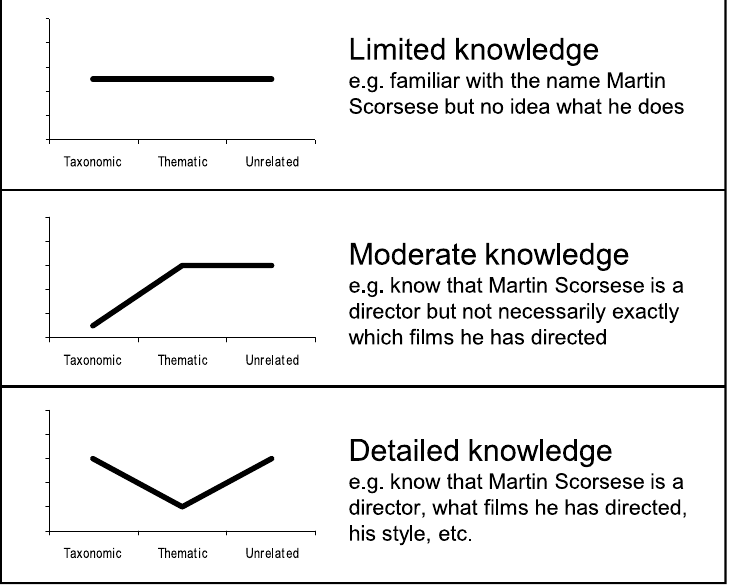
Fig. 2. Hypothetical patterns of performance across the taxonomic, thematic and unrelated conditions for different degrees of personal knowledge. as demonstrated by NBC on task 2d, indicates that the verbal labels are within one’s vocabulary but little